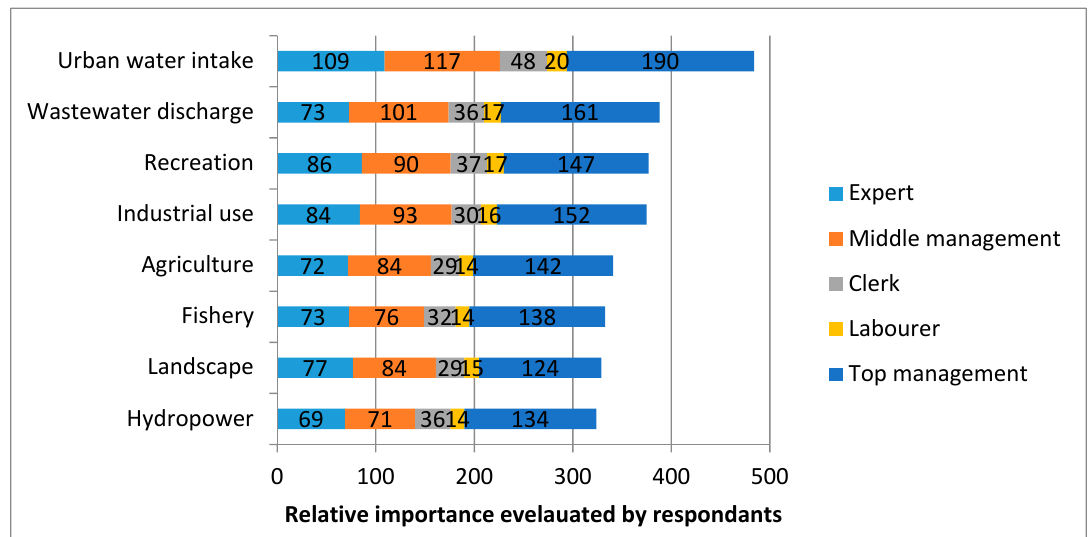
Figure 1. Ranking of water use priorities, illustrated by occupational groups.